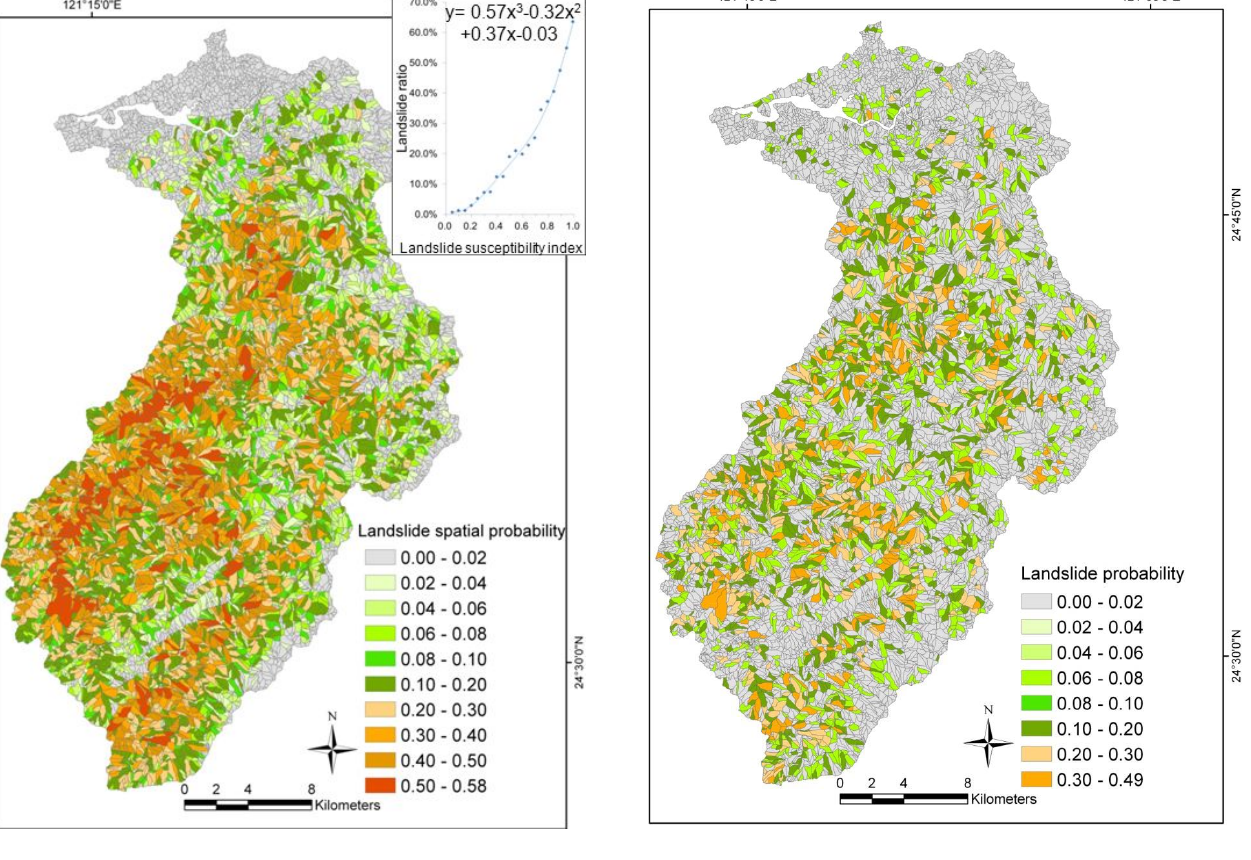
Fig. 7. Landslide spatial probability for the established model. The landslide susceptibility indices in Fig. 5 were converted to landslide spatial probability using the relationship as demonstrated in the upper right corner.